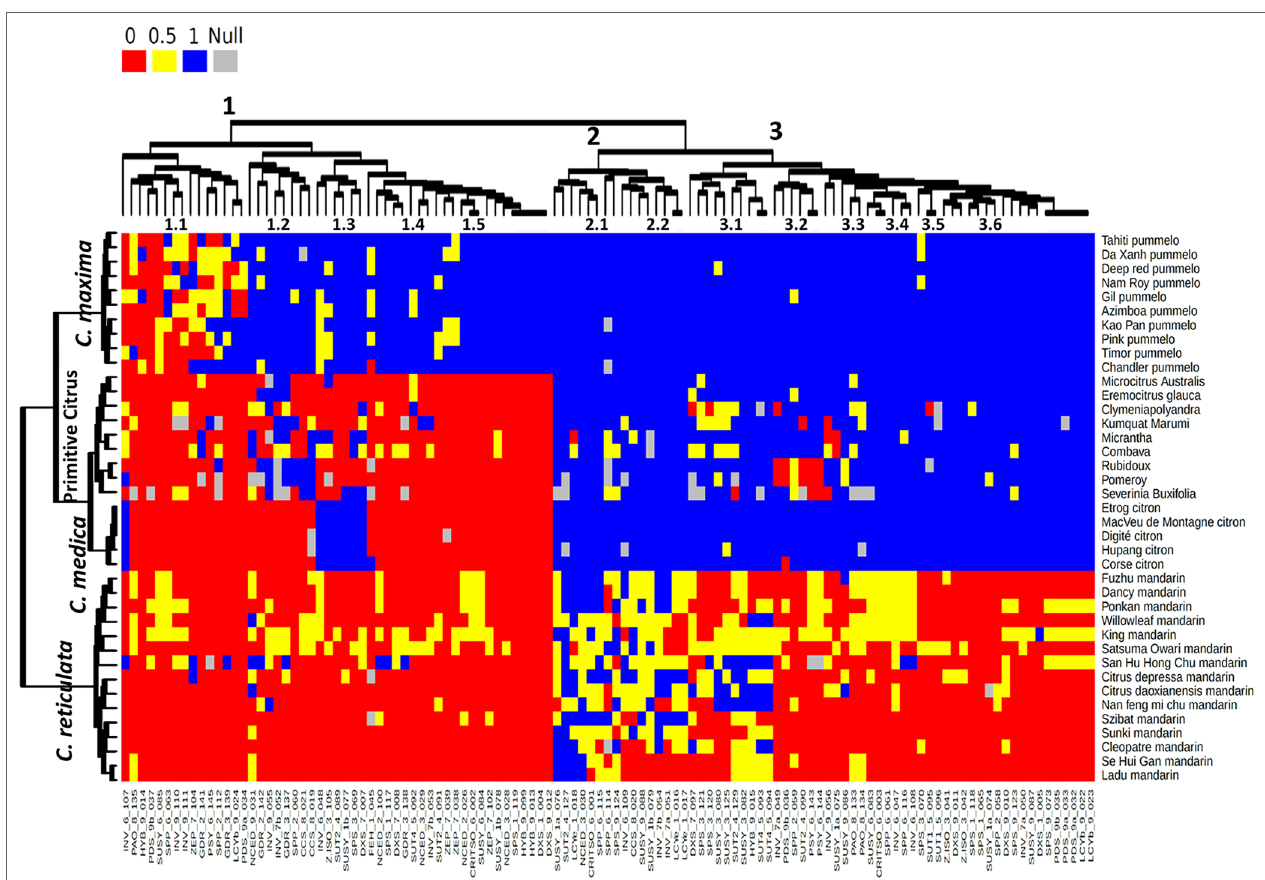
FIGURE 4 | Heatmap of 67 genotyped citrus varieties along with 115 SNP markers. The red, blue, and yellow colors correspond to SNP homozygous for the C. reticulata allele (0), homozygous for C. maxima allele (1), and heterozygous (0.5), respectively. Gray color indicates null alleles (undefined